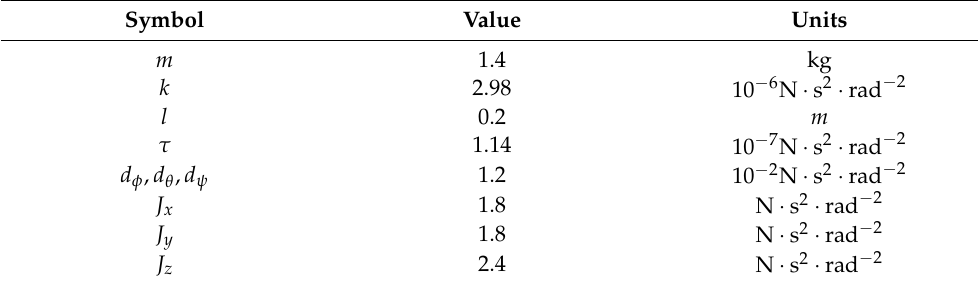
Table 2. The design parameters of the